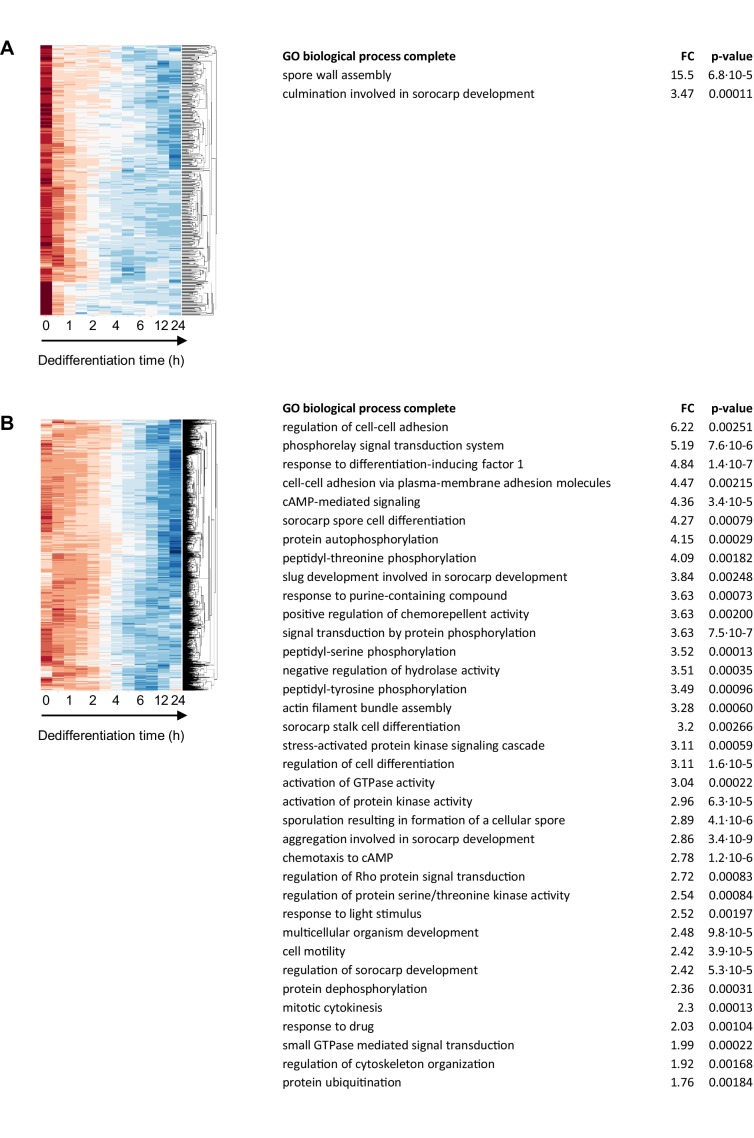
Functional enrichment analysis of genes repressed during dedifferentiation.Left panels show enlarged segments of Figure 2—figure supplement 5 showing (A) ‘early off’ (412 genes) and (B) ‘late off’ (1774) clusters. The accompanying GO tables are shown on the right, with ‘early off’ genes enriched for terminal differentiation terms and ‘late off’ genes enriched for signalling, adhesion, differentiation and chemotaxis terms.